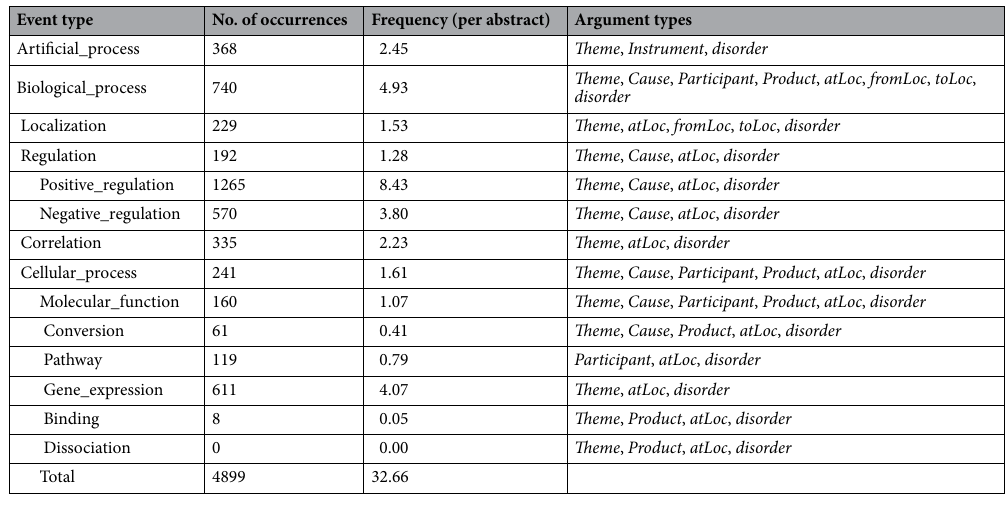
Table 2. Event types and their occurrences along with their argument